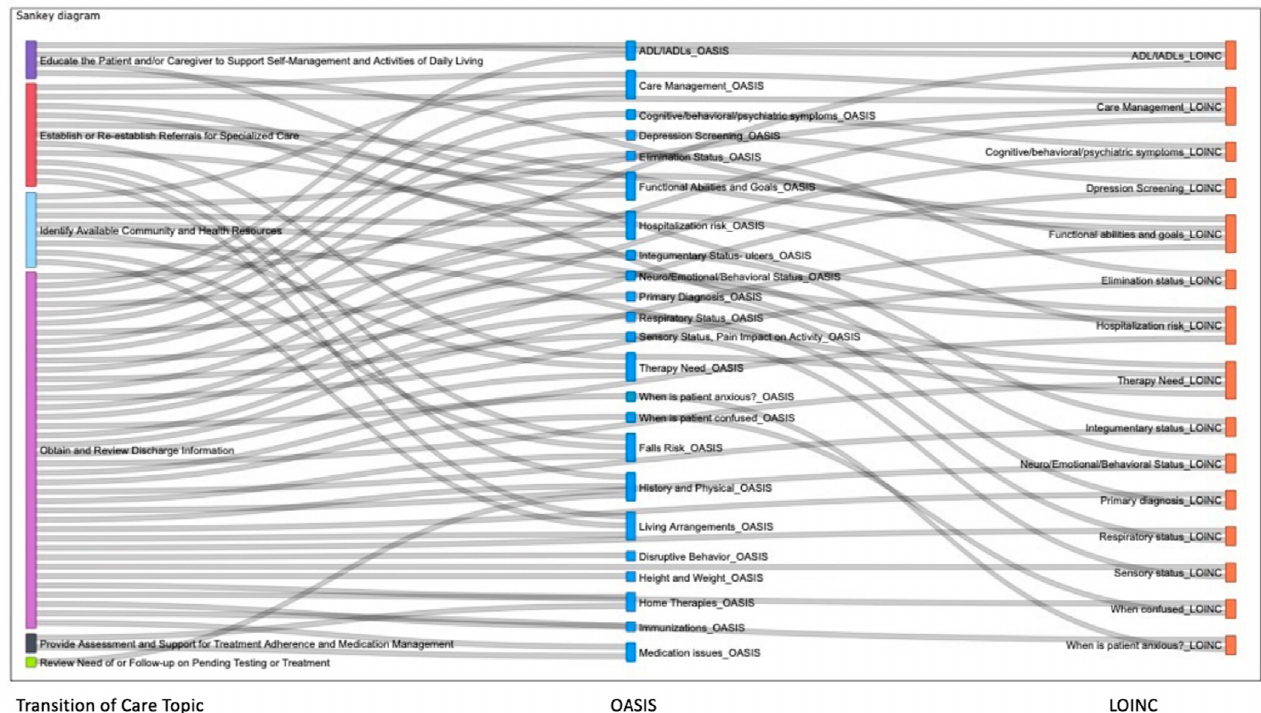
Figure 1. Stacked Bar Graph of Count of LOINC Codes and OASIS Concepts Mapped to Transition of Care Topics.